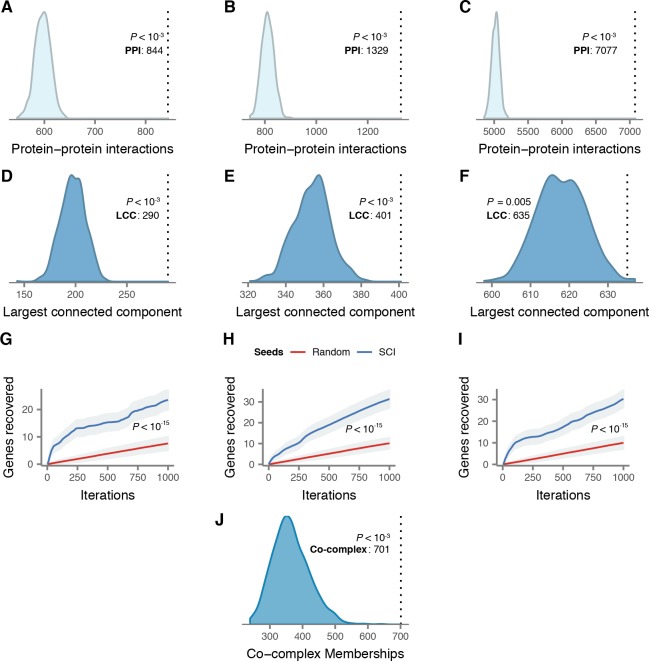
Validation of the complete set of genes implicated in the physiological response to SCI.(A–C) Number of protein-protein interactions (PPIs) between LC genes in the InBioMap (A) (Li et al., 2017) and binary (B) or co-complex (C) subsets of the HINT (Das and Yu, 2012) human interactome databases (dotted lines) and 1000 randomized interactome networks (densities), confirming significant enrichment for PPIs between LC genes relative to random expectation (all p < 10–3). (D–F) Size of the largest connected component (LCC) between LC genes in the InBioMap (D) and binary (E) or co-complex (F) subsets of the HINT human interactome databases (dotted lines) and 1000 randomized interactome networks (densities), confirming significant enrichment for PPIs between LC genes relative to random expectation (all P
≤ 0.005). (G–I) LC genes are prioritized by a disease gene prediction algorithm (Ghiassian et al., 2015) in the InBioMap (G) and HINT binary (H) or co-complex (I) human interactomes (all p < 10–15). (J) Number of intra-complex co-memberships between LC genes (dotted line) and 1000 randomized gene sets (density) observed in a global map of human protein complexes (Drew et al., 2017), revealing significant tendency for LC genes to participate in the same protein complex (p < 10–3).